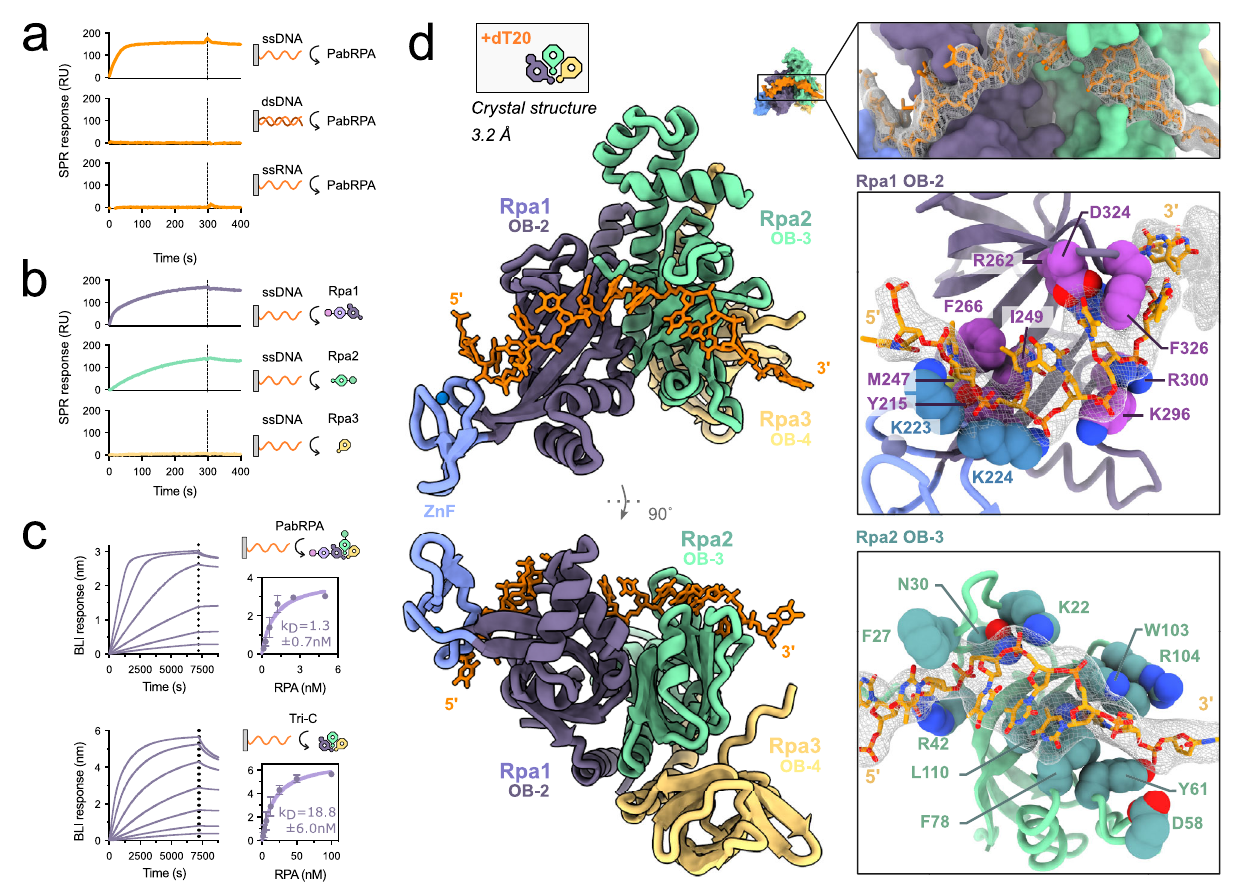
Fig. 2 | Structural basisfor the DNA-binding activitybyPabRPA. a Nucleicacid- bindingspeci fi cityforPabRPA.BindingofPabRPAat5nMproteinconcentrationon immobilized ssDNA-32mer, dsDNA-32mer, and ssRNA-32mer measured by surface plasmon resonance (SPR) (RU: resonance units). b Role of PabRPA subunits on ss DNA binding. Speci fi c binding of Rpa1, Rpa2, or Rpa3 at 500nM on immobilized ssDNA-32mermeasuredbySPR. c Speci fi cbindingofPabRPAfull-length(5,2.5,1.25, 0.63, 0.31, 0.16nM PabRPA; n =2) or Tri-C (100, 50, 25, 12.5, 6.25, 3.2, 1.6nM Tri-C;